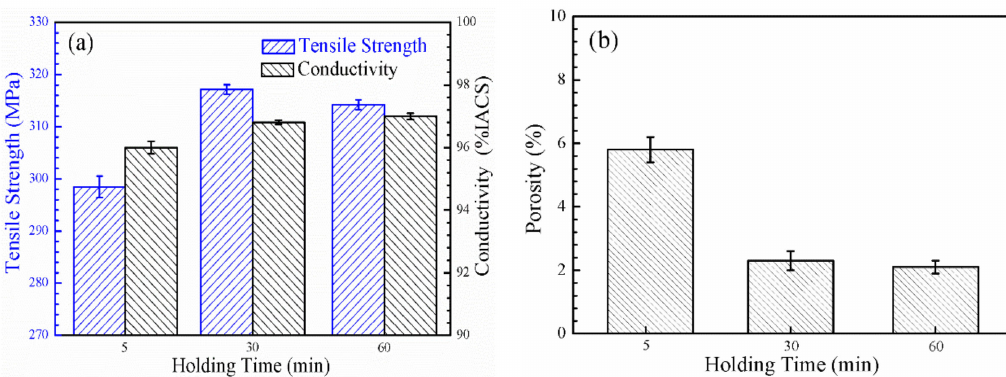
Figure 4. Properties of the nano-Gd 2 O 3 /Cu composite with holding time: ( a ) tensile strength and conductivity; ( b )